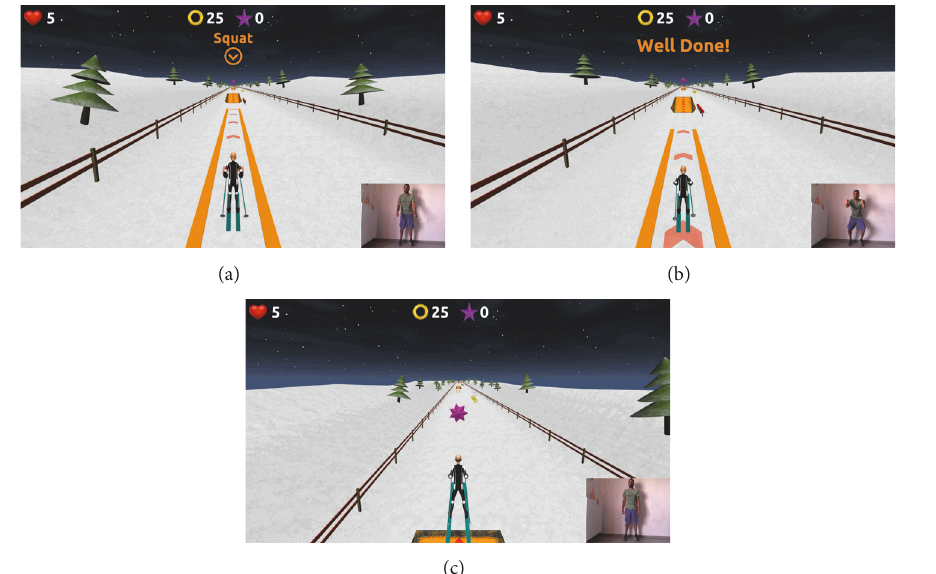
Figure13:SlopeCreepgame.(a)Thehumanactorisdirectedtosquat;(b)thesquatofthehumanactor(seebottom-rightinsert)isrecognized; (c) as a result, the avatar picks up speed and performs a high jump to collect the purple star.